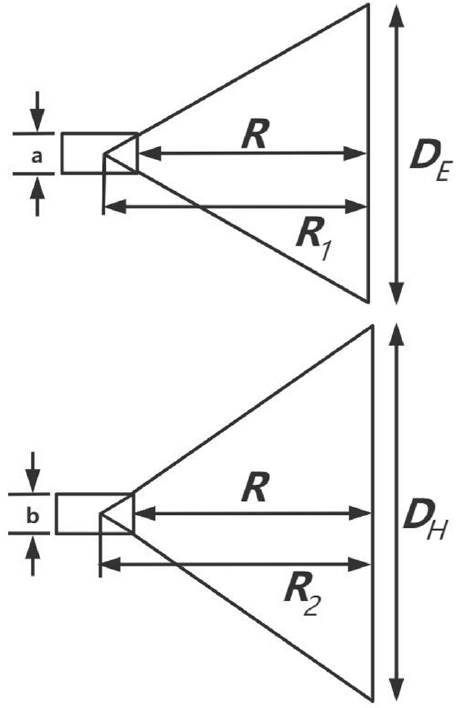
Figure 4. Antenna schematic diagram of E-plane and H-plane. In the process of antenna design, the beam angle HP 0 and HP 0 of horn antenna can E H be calculated for the given sizes of HP E and HP H without constraint. In order to design the optimum horn under constraints on the half-power beam width, we have found that one of the parameters, s or t , has to retain the value t = 0.375 and s = 0.25 of the optimum horn, while the other parameter changes. In this paper, the required ratio k of E-plane and H-plane beams is introduced to determine the adjustment mode of the two beam